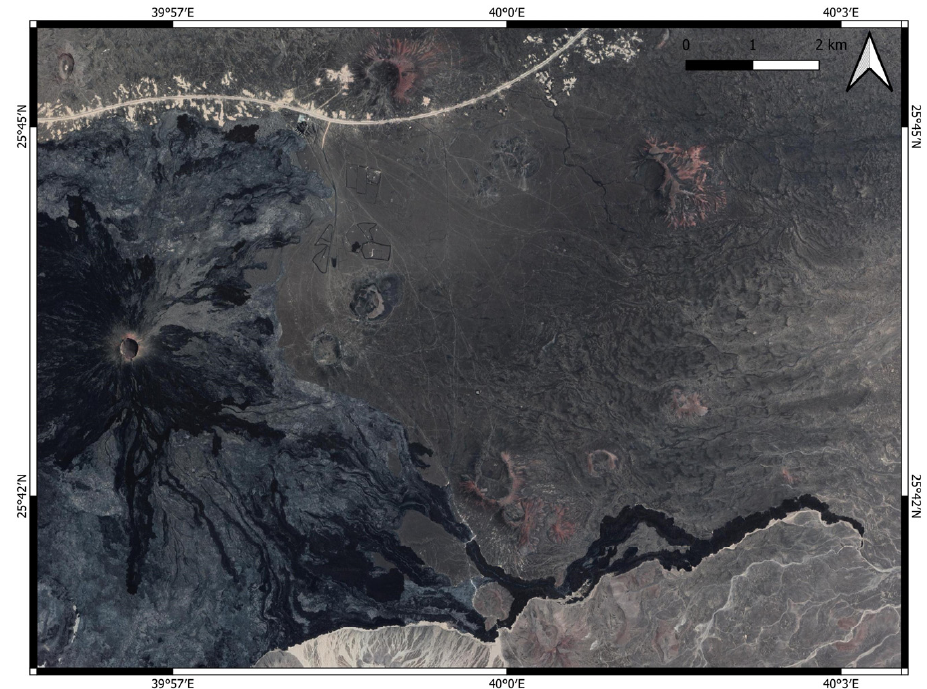
Figure 9. The eastern zone of Jabal Quidr on a Sentinel satellite image with a characteristic lava channel that transforms into a rubbly p¯ahoehoe from the inflated tube-fed zones in the foothill area. Lava is diverted toward the south to pass the pre-eruptive obstacles formed by older cones. An ash plain covers the pre-eruptive landscape, indicating that the lava flow emplacement post-dates the major explosive phase and scoria cone growth of Jabal Quidr.